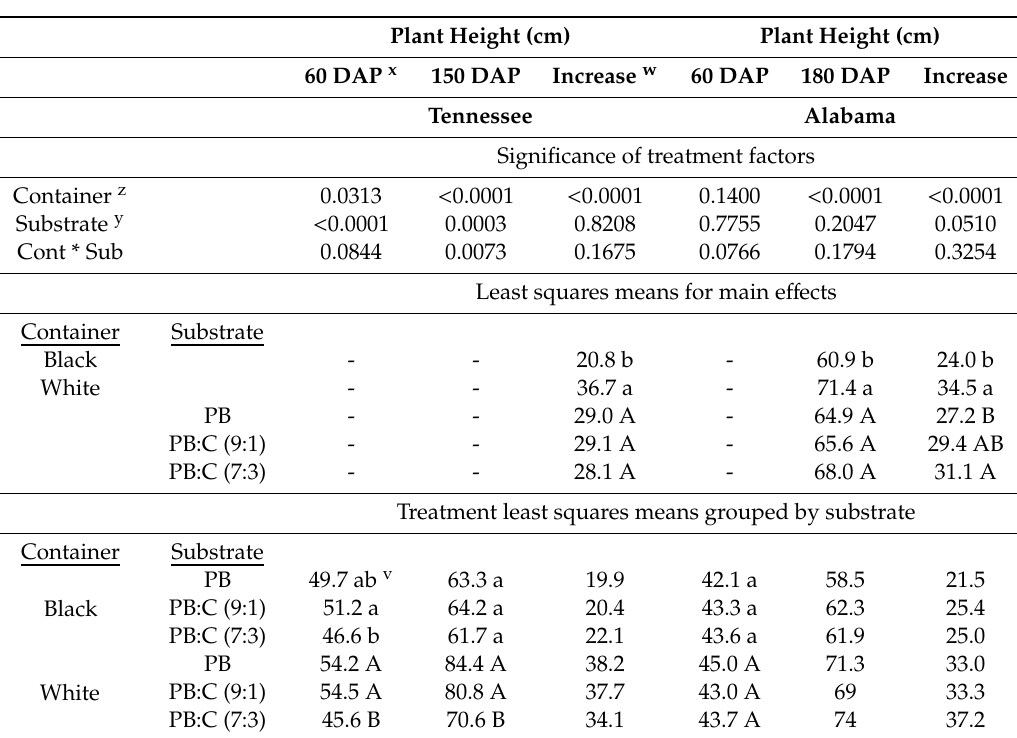
Table 3. Plant height and height increase of “Green Giant” arborvitae grown in two containers and three substrates in Tennessee (McMinnville) and Alabama